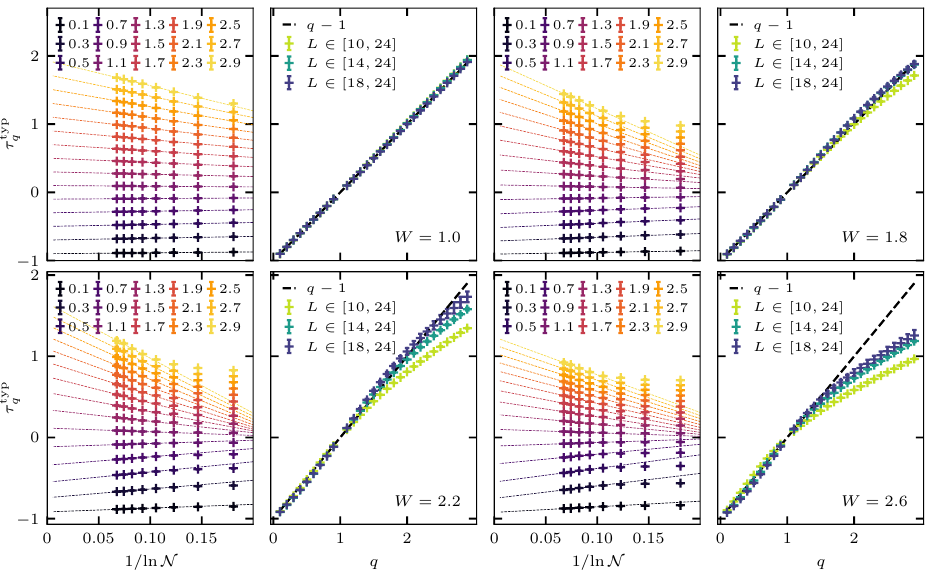
Figure 3: Similar to Fig. 2, but for τ typ